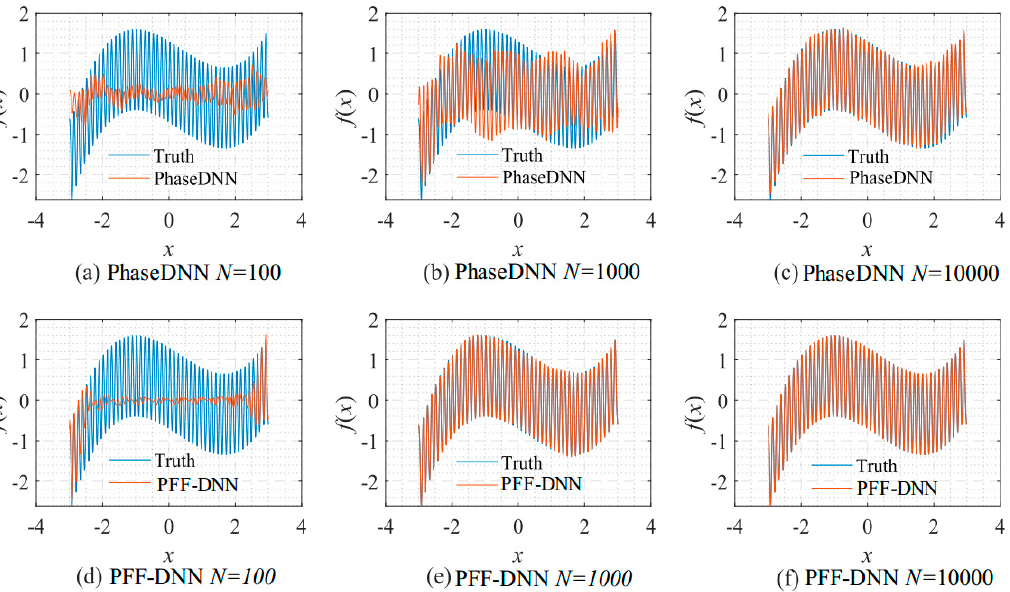
Figure 9. The influence of N on the algorithm performance. Fitting results of the PhaseDNN method when Δ ω = 11: ( a ) N = 100; ( b ) N = 1000; and ( c ) N = 10,000. Fitting results of the PFF-DNN method when Δ ω = 11: ( d ) N = 100; ( e ) N = 1000; and ( f ) N = 10,000.